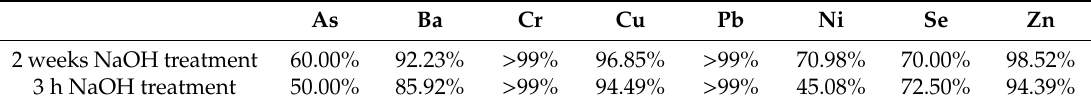
Table 1. Leaching of heavy metals from MSWIBA after NaOH pre-treatment. As Ba Cr Cu Pb Ni Se Zn 2 weeks NaOH treatment 60.00% 92.23% > 99% 96.85% > 99% 70.98% 70.00% 98.52% 3 h NaOH treatment 50.00% 85.92% > 99% 94.49% > 99% 45.08% 72.50%